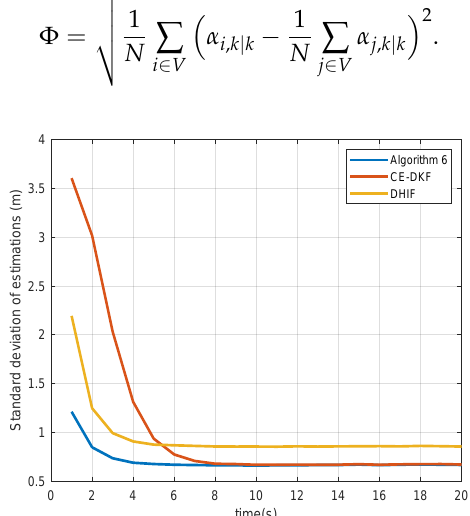
Figure 4. Standard deviation of estimations ( Q = Q 1